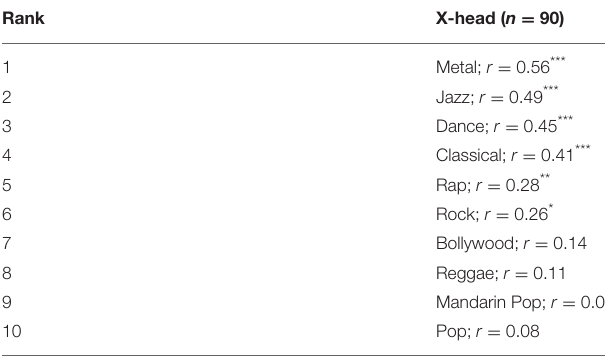
TABLE 6 | Table showing the ranked order of